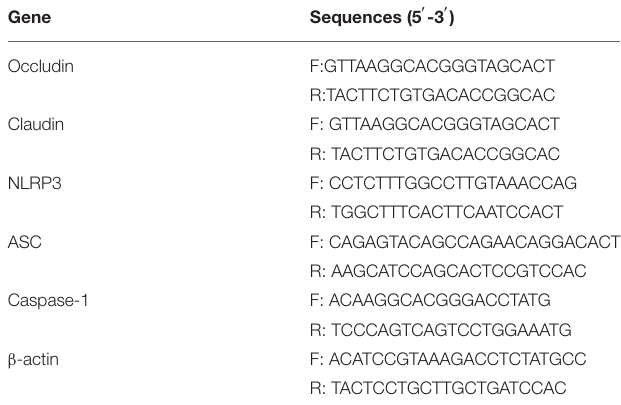
TABLE 1 | All primer sequences were used in the